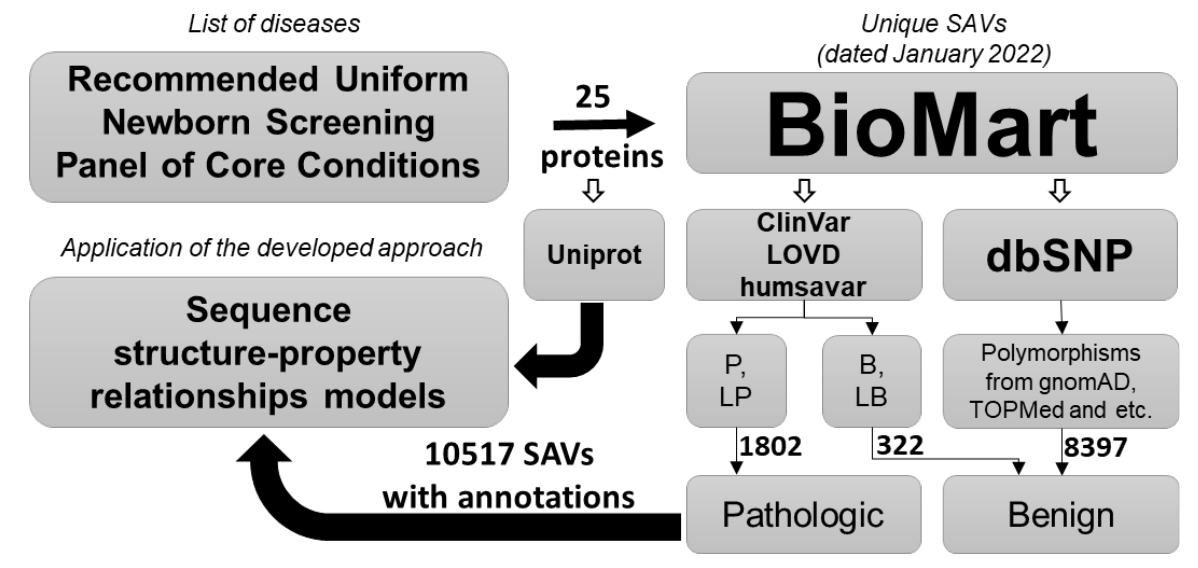
Figure 1. Illustration of the project workflow. SAVs – single amino acid variants, P – pathogenic, LP – likely pathogenic, B – benign, LB – likely benign.